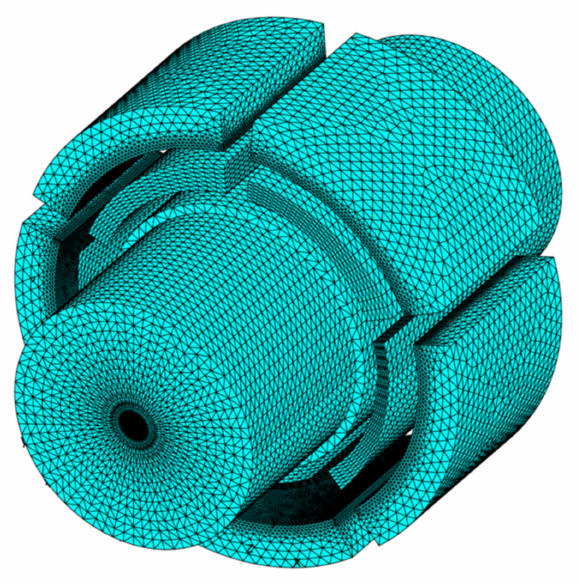
Figure 2. Mesh of the thermal model. Oil-film parts are magnified in the